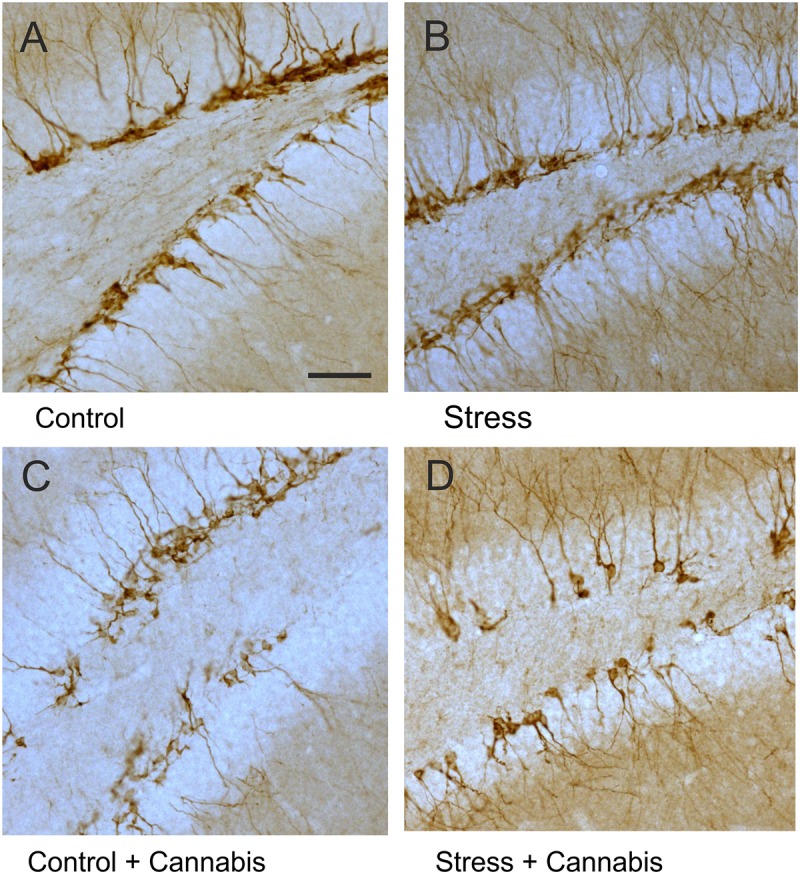
DCX-positive immature neurons in the dentate gyrus. Representative images demonstrating DCX-immunohistochemistry staining in the dentate gyrus of animals from the different treatment groups (A–D). Note that DCX-positive cells were often disarrayed in the dentate gyrus of cannabis treated mice (C,D). Scale bar: 50 μm for all images.